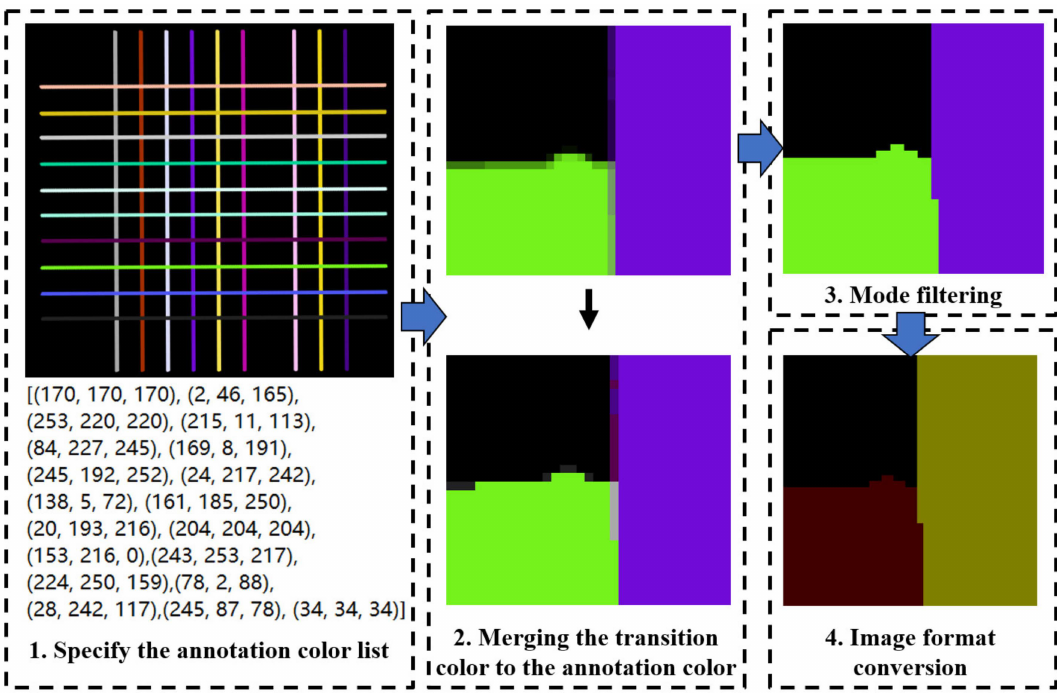
Figure 9. Annotation image processing